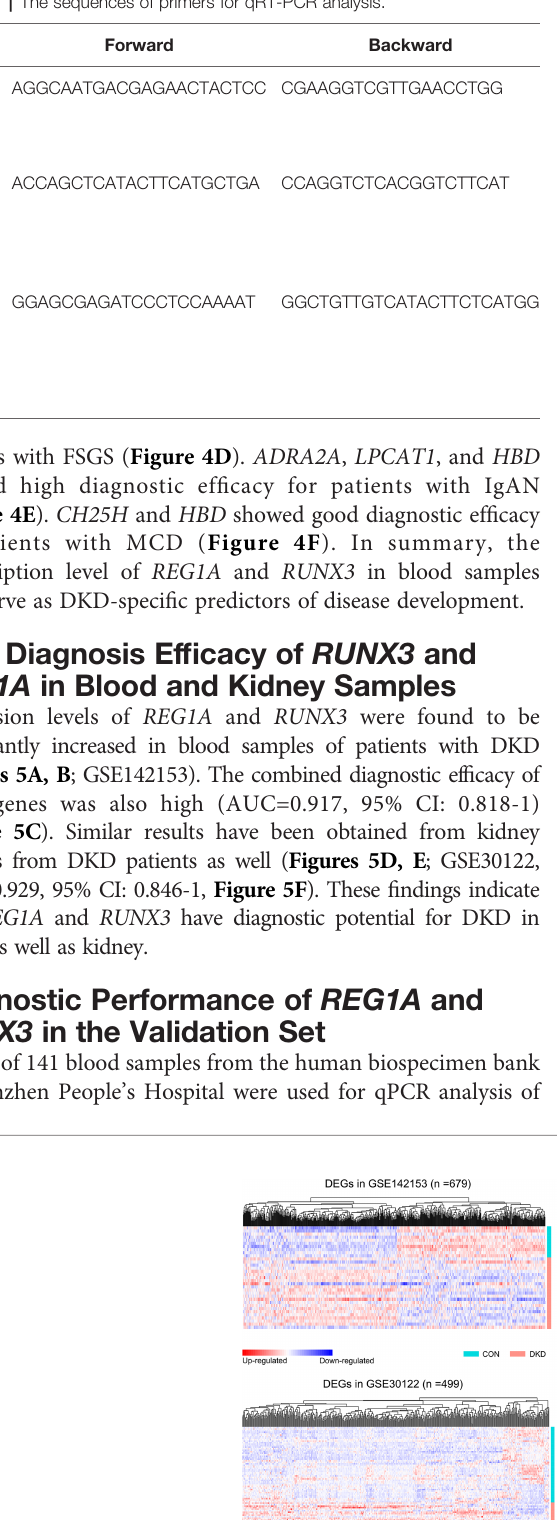
TABLE 1 | The sequences of primers for qRT-PCR analysis.